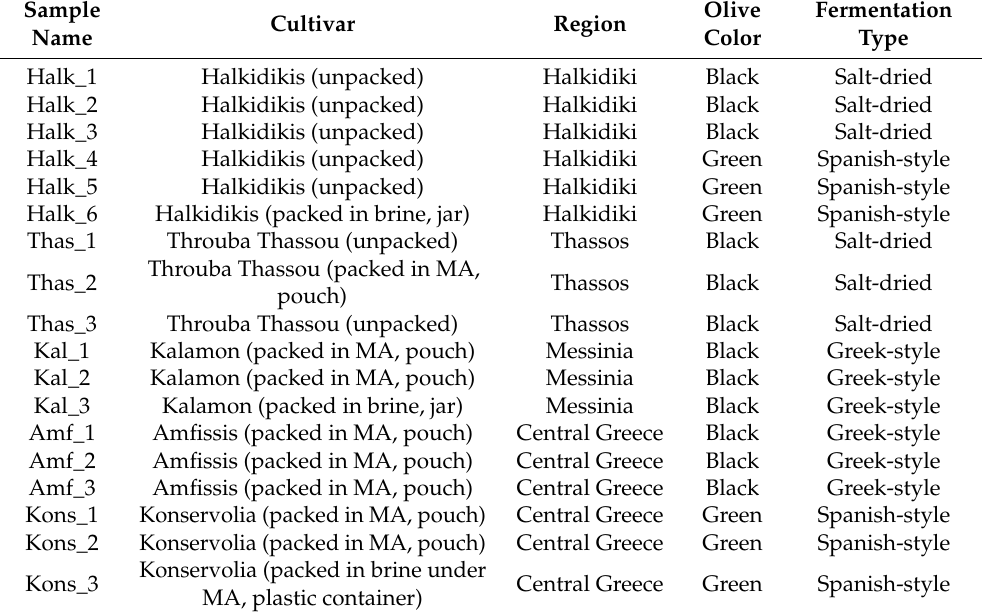
Table 1. Description of the samples studied. MA; modified